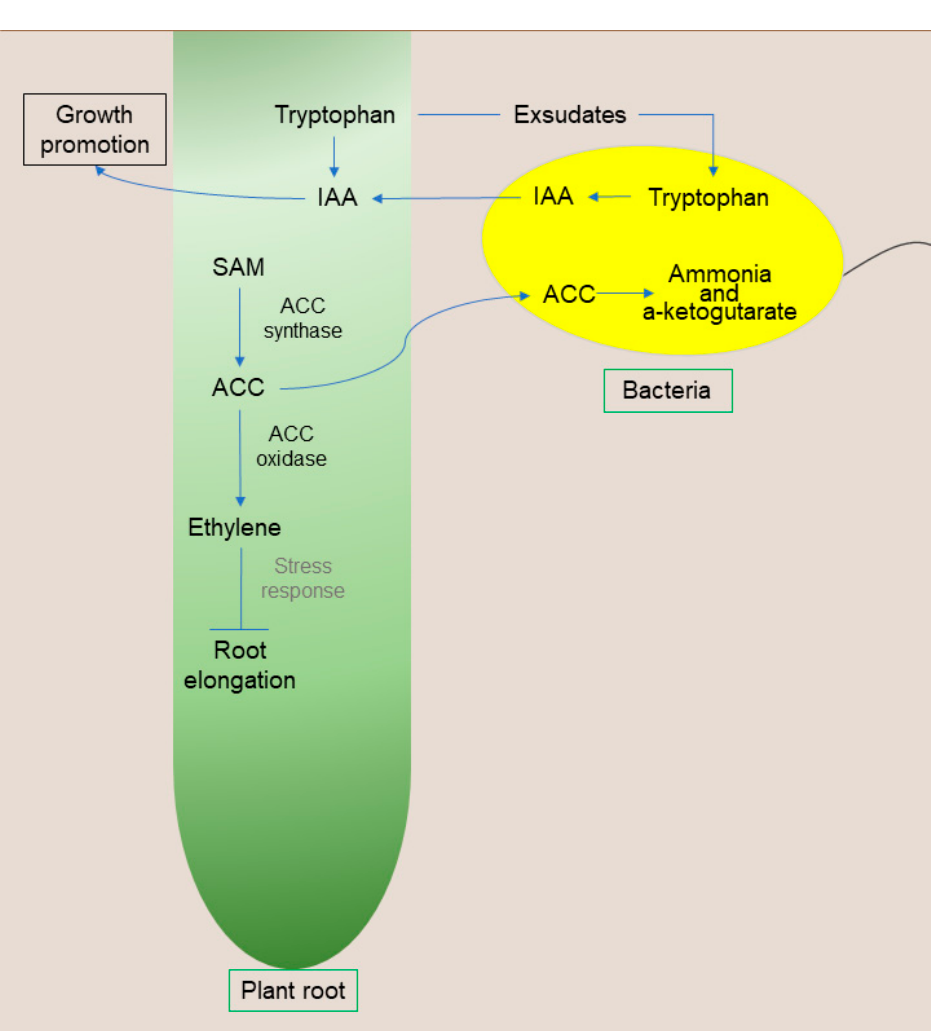
Figure 3. Schematic representation of bacteria with ACC deaminase activity. Abbreviations: AIA, auxin; SAM, S-adenosylmethionine; ACC, 1-aminocyclopropane-1-carboxylate; ACC deaminase, 1-aminocyclopropane-1-carboxylate deaminase; BNF, biological nitrogen fixation. Organisms and cells are not to scale.